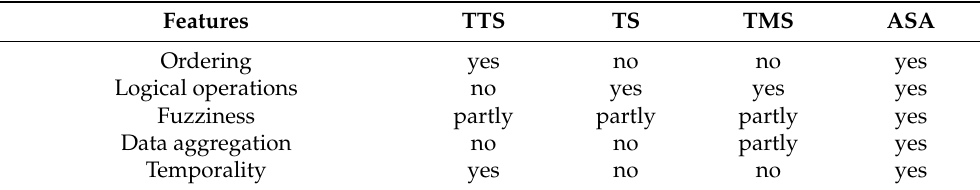
Figure 3. An example of two incompatible aggregates.